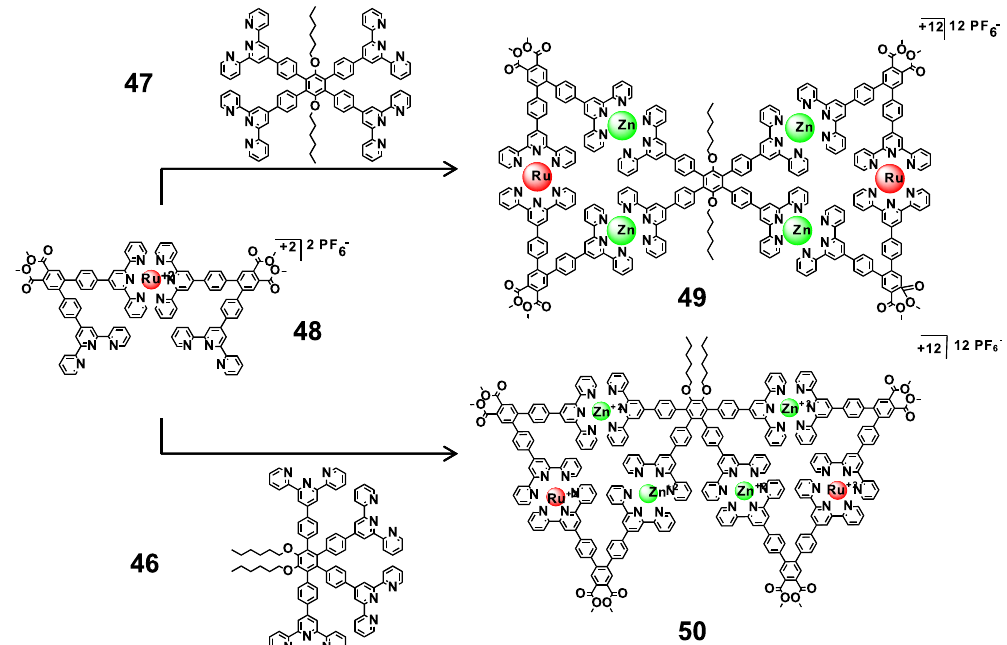
FIGURE 21 – Self-assembly of isomeric bowtie and butterfly bicyclic metallomacrocycles 49 and 50 , respectively [Schultz, A.; Li, X.; Barkakaty, B.; Moorefield, C. N.; Wesdemiotis, C.; Newkome, G. R. J. Am. Chem. Soc. , v.134, p.7672-7675, 2012. – Reproduced by permission of The American Chemical